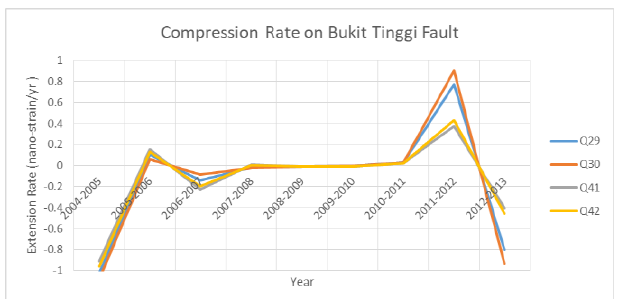
Figure 21. Compression rate changes on Bukit Tinggi Fault’s Quasi Network points (Q29, Q30, Q41 and Q42) from 2004 to